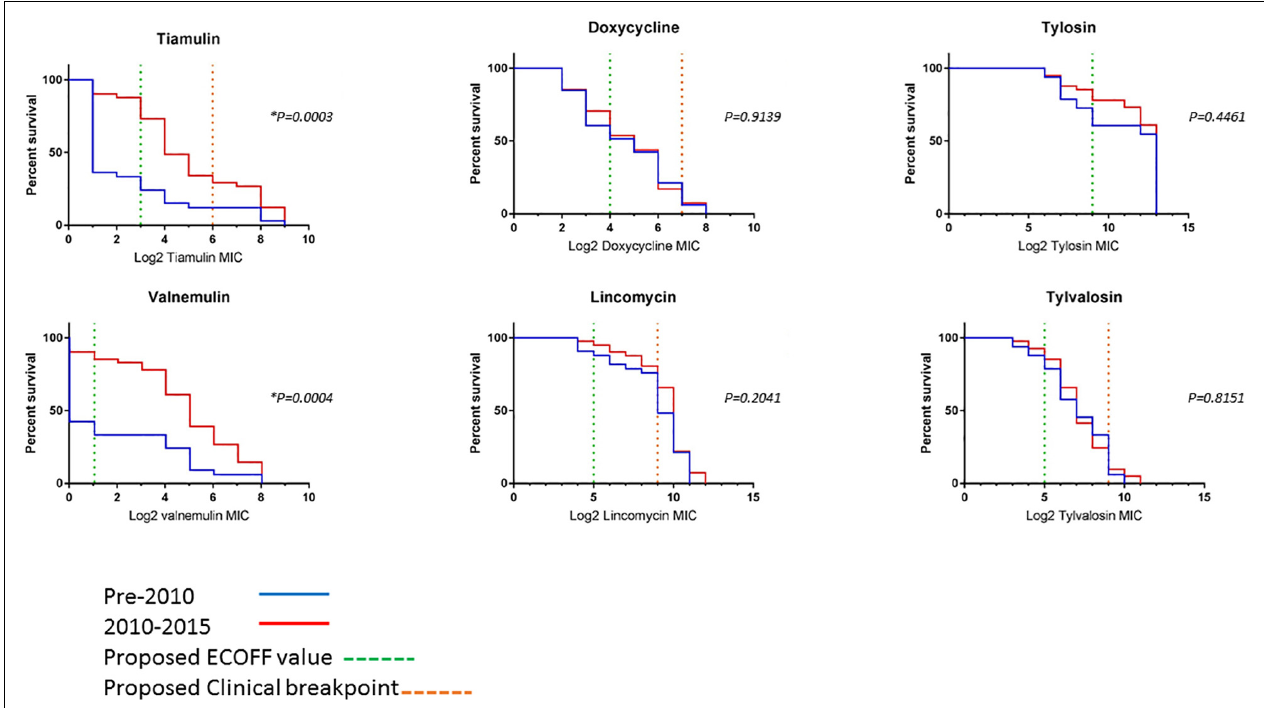
FIGURE 3 | Survival curves of log2 MIC values of six antimicrobials for 73 UK isolates. The pre-2010 group is the blue line and the 2010–2015 group is the red line. The green dashed line is the proposed ECOFF value and the orange dashed line is the proposed clinical resistance breakpoints (where applicable) ( Supplementary Table 6 ). *Indicates a statistically significant value.